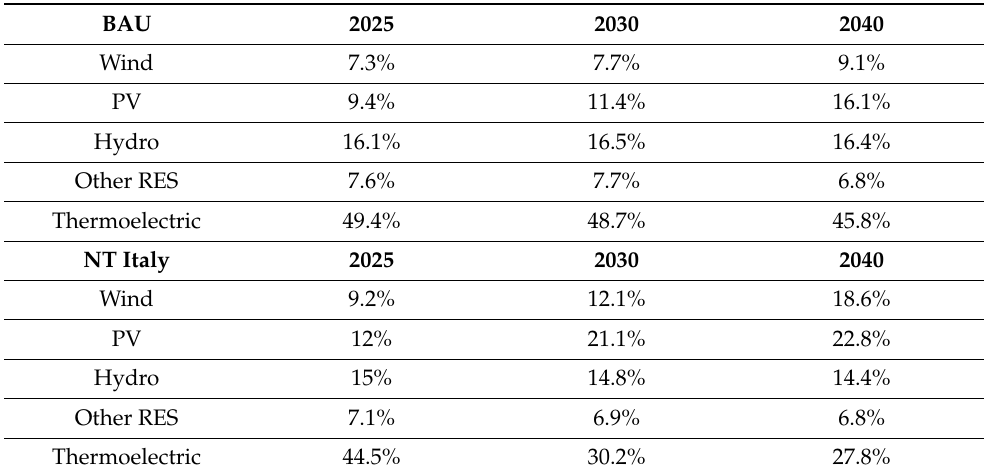
Table 5. Generation mix in time horizon 2025, 2030, 2040 in Italy for BAU and NT Italy scenarios.